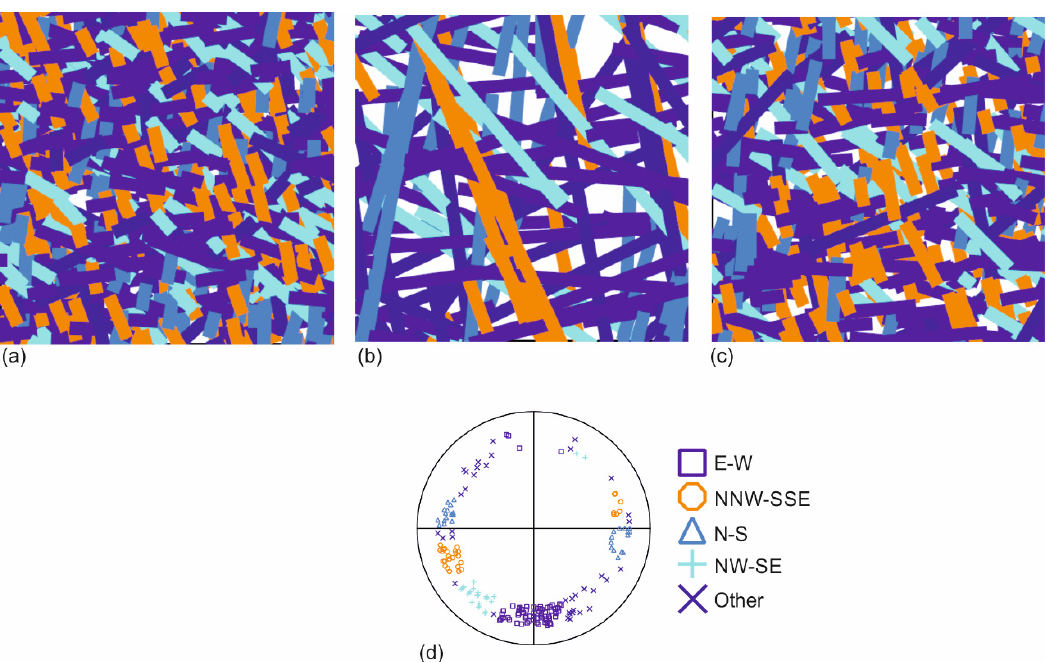
Figure 6. Top view of an 80 per 80 m section of the total generated fracture network model: ( a ) base-case fracture network; ( b ) fracture network with fracture lengths increased by a factor of 10; ( c ) fracture network with fractal dimension decreased by a factor of 2; ( d ) Wulff projection stereo plot of field fracture data. Adapted from Miranda et al. [51].